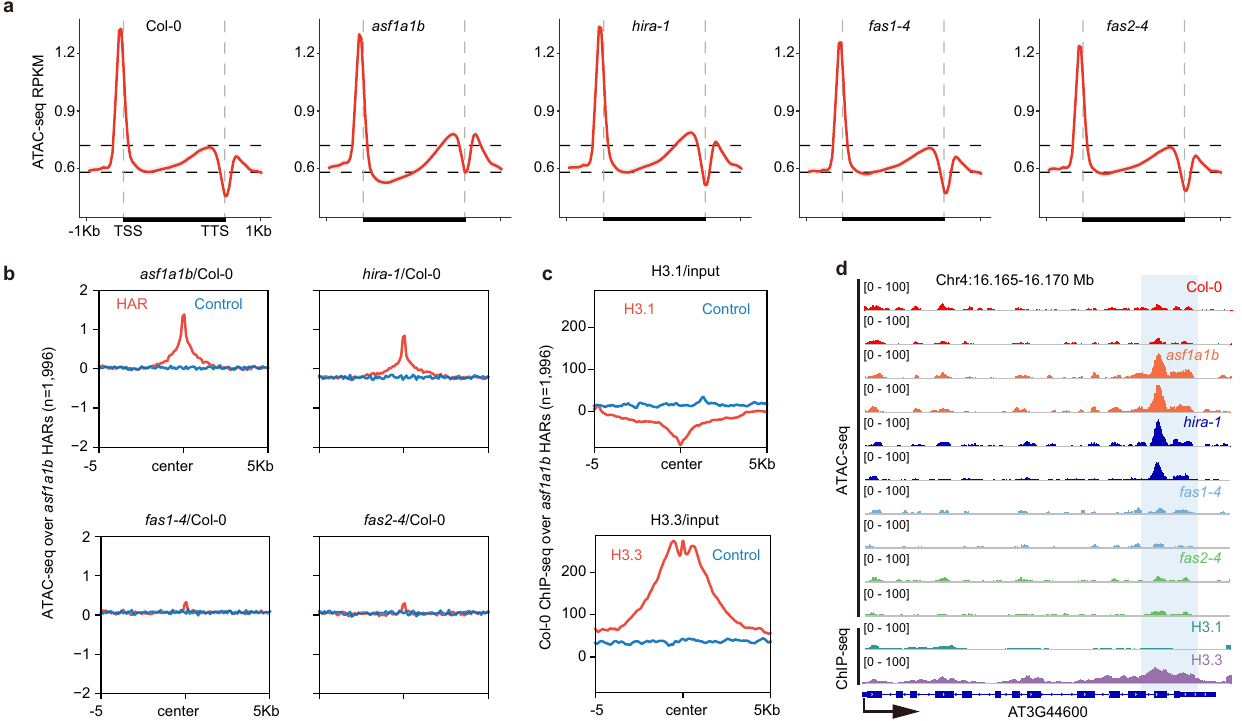
Fig. 1 | Effect of H3 Histone chaperone mutants on chromatin accessibility. a Metaplotof ATAC-seqsignals ofCol-0, asf1a1b , hira-1 , fas1-4 , and fas2-4 overthe genebody,including1Kb fl ankingsequencesofgeneswithcodingregionslengths over 150bp ( n =26816). b Metaplot of ATAC-seq signals of asf1a1b /Col-0, hira-1 / Col-0, fas1-4 /Col-0, fas2-4 /Col-0 over asf1a1b highly accessible regions (HAR, n =1996). The blue line represents metaplot of randomly selected control regions